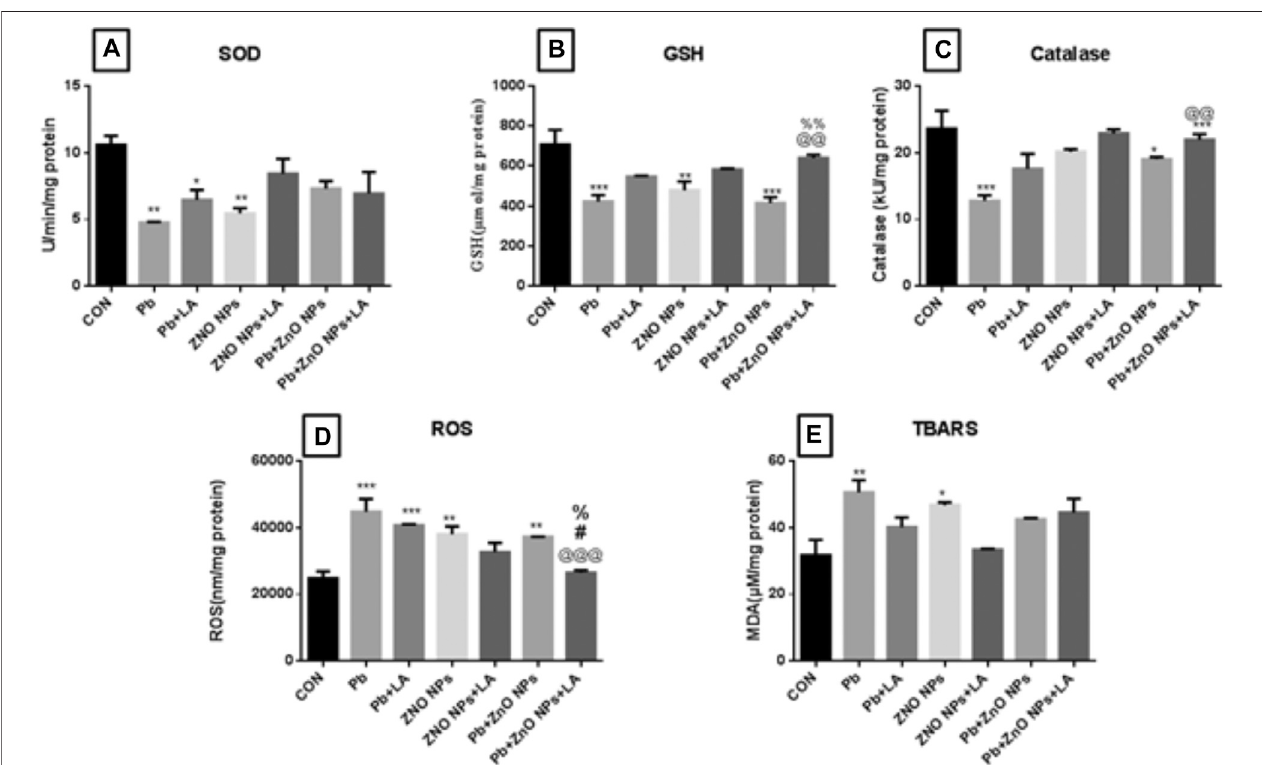
FIGURE 7 | Spleen biochemical parameters. (A) SOD activity; (B) GSH activity; (C) catalase activity; (D) ROS level; and (E) TBARS level. All the values are expressed as mean ± SEM (n (cid:2) 4). The statistical signi fi cance was considered at p < 0.05, and statistical analysis was performed using one-way ANOVA, followed by Tukey ’ s test. * p < 0.05, ** p < 0.01, *** p < 0.001 vs. control; @@ p < 0.01, @@@ p < 0.001 vs. lead; # p < 0.05 vs. ZnO NPs; % p < 0.05, %% p < 0.01 vs. PB + ZnO